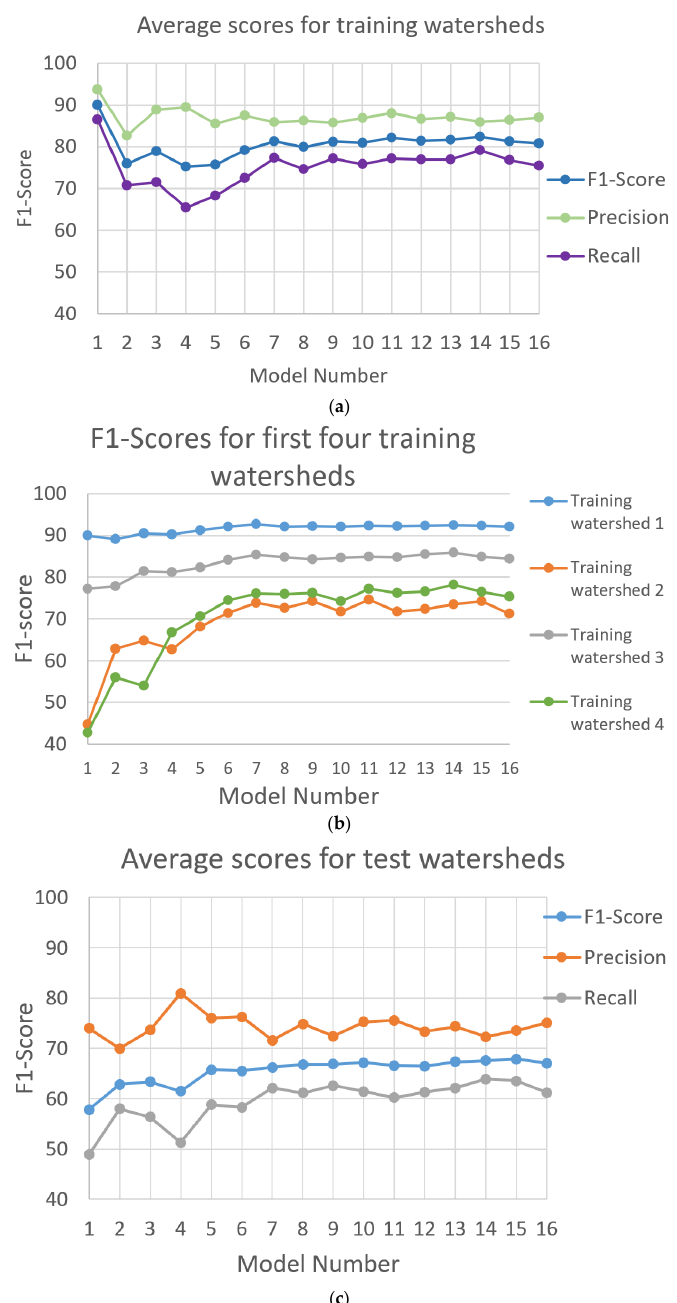
Figure 8. Average accuracy values of precision, recall, and F1-score for ( a ) training watersheds and ( c ) test watersheds in the 50-watershed study area in Alaska determined from hydrographic feature predictions from 16 U-net models that use an increasing number of training watersheds. (Note: Model 1 was trained with watershed 1, model 2 was trained with watersheds 1 and 2, and model 3 was trained with watersheds 1, 2, and 3, and so forth to model 16). Model 1 averages are the accuracy values for training watershed 1, and model 2 averages are determined from accuracy values for training watersheds 1 and 2, and so forth to model 16 that shows averages for all 16 training watersheds. Panel ( b ) shows average values for the first four training watersheds. Averages for test watersheds ( c ) are determined from the 49 to 34 watersheds that are not used for training models 1 to 16, respectively. Reference features are rasterized 1:24,000-scale hydrographic features derived from 2012–2013 IfSAR data through work contracted by the U.S. Geological Survey in September